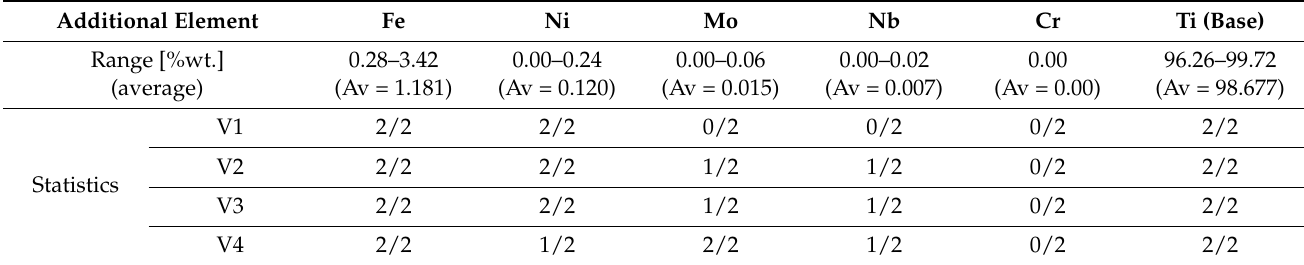
Table 5. Results of chemical analysis performed on the external cylindrical surfaces of the manufactured rods. Results obtained by X-ray fluorescence spectrometry. Description: [%wt.]—content in weight percent, Av—average value. Statistic— number of detected cases per two measurements (two surface measurements were made for each variant). Error of measurements: Ti ± 0.05; Fe ±